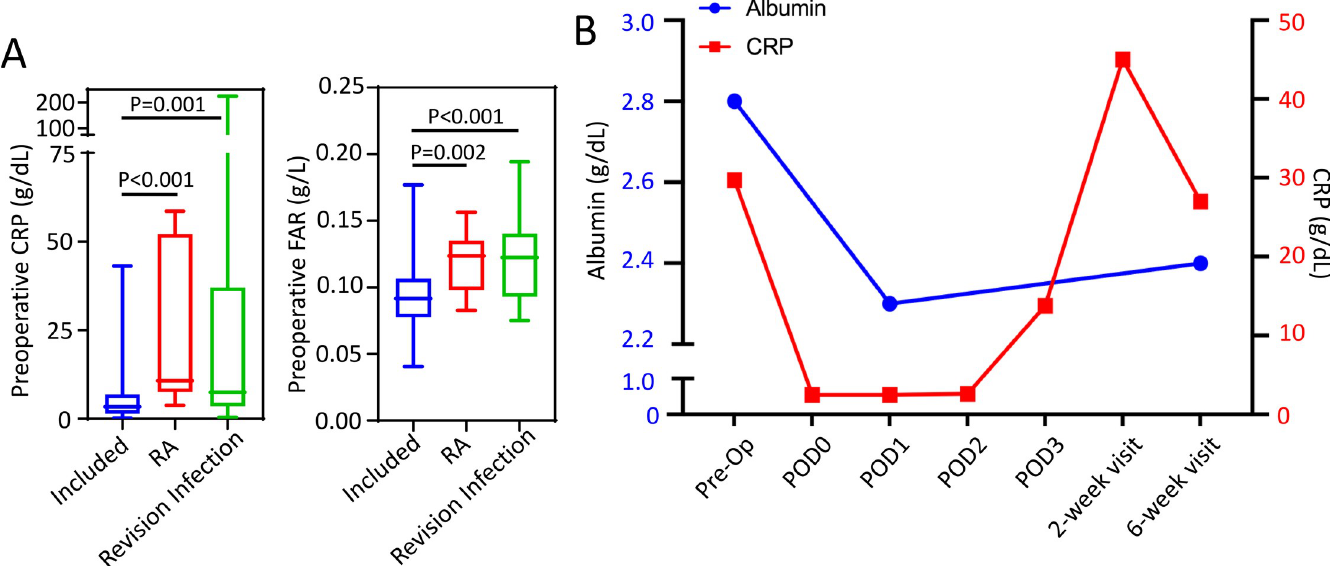
Fig 3. A) Comparison of preoperative CRP and fibrinogen/albumin ratio (FAR) in included study patients (N = 157) and those excluded for rheumatoid arthritis (N = 9) or necessitating a revision TKA due to periprostatic infection (n = 32). Whiskers represent the range of data. Cohorts were compared using a non-parametric ANOVA (Kruskal Wallis test) given that data was nonnormally distributed, α = 0.05. B) Median circulating albumin (blue) and CRP (red) following TKA in a patient with cirrhosis who developed wound dehiscence at postoperative week 2. Y-error bars depict a CI of 95%.